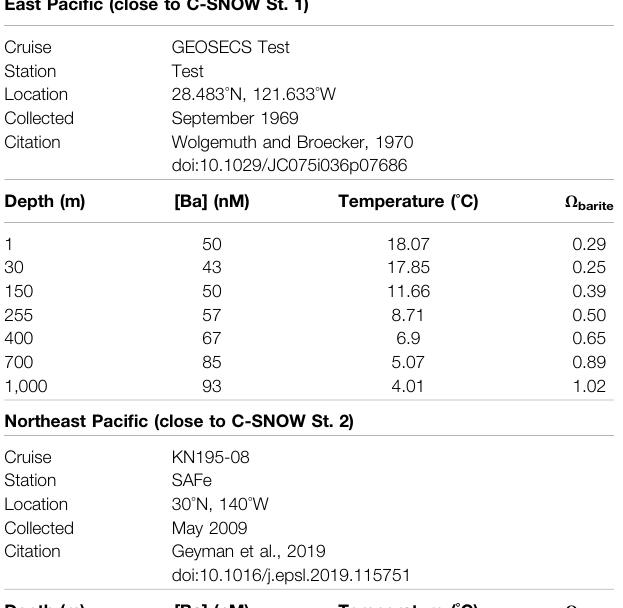
TABLE 2 | Dissolved Ba, temperature, and calculated pro fi les of dissolved Ω barite across depth in nearby stations to those analyzed in this work (co-located dissolved samples were generally not available for our study).